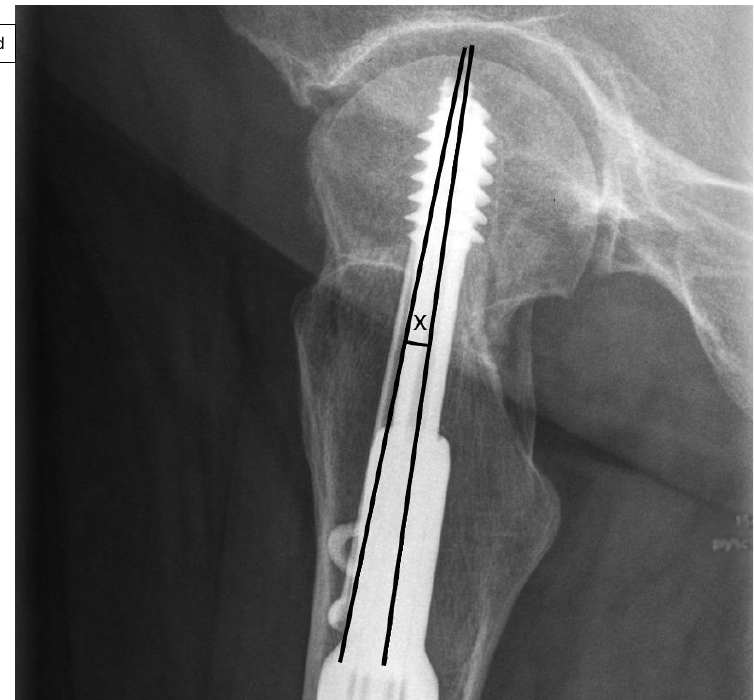
Figure 2. Measurement of the femoral neck angle (*) compared to the contralateral side (°), defined as the angle between the femoral neck axis and the bisecting line of the femoral shaft ( a ). The tip- apex distance (TAD) was defined as the calibrated summation of the distance between the tip of the SHS and the apex of the femoral head on anteroposterior and (not demonstrated) lateral radio- graphs (mm) ( b ), and the angle between SHS and ASR in the frontal plane (#) ( c ) and the axial plane (x) ( d ) by using biplanar conventional radiographs, six weeks postoperatively. In each follow-up visit, the healing time (weeks) and failure rate as well as potential surgery-related complications were examined. Hereby, treatment failure was defined as cutting out of the SHS, and respectively the ARS, collapse of the femoral head, implant loosening, or failure of fracture healing up to 6 months after surgical stabilization. Frac- ture healing was defined as osseous union of at least three cortices diagnosed by biplanar conventional radiographs [15]. 2.4. Follow-Up After discharge from the hospital, patients were followed-up clinically and radiolog- ically in the outpatient department at regular intervals after 6 weeks, followed by 4-week intervals until the sixth month after surgical stabilization of the femoral neck fracture or until fracture healing was documented. In addition, in case of suspected complications,